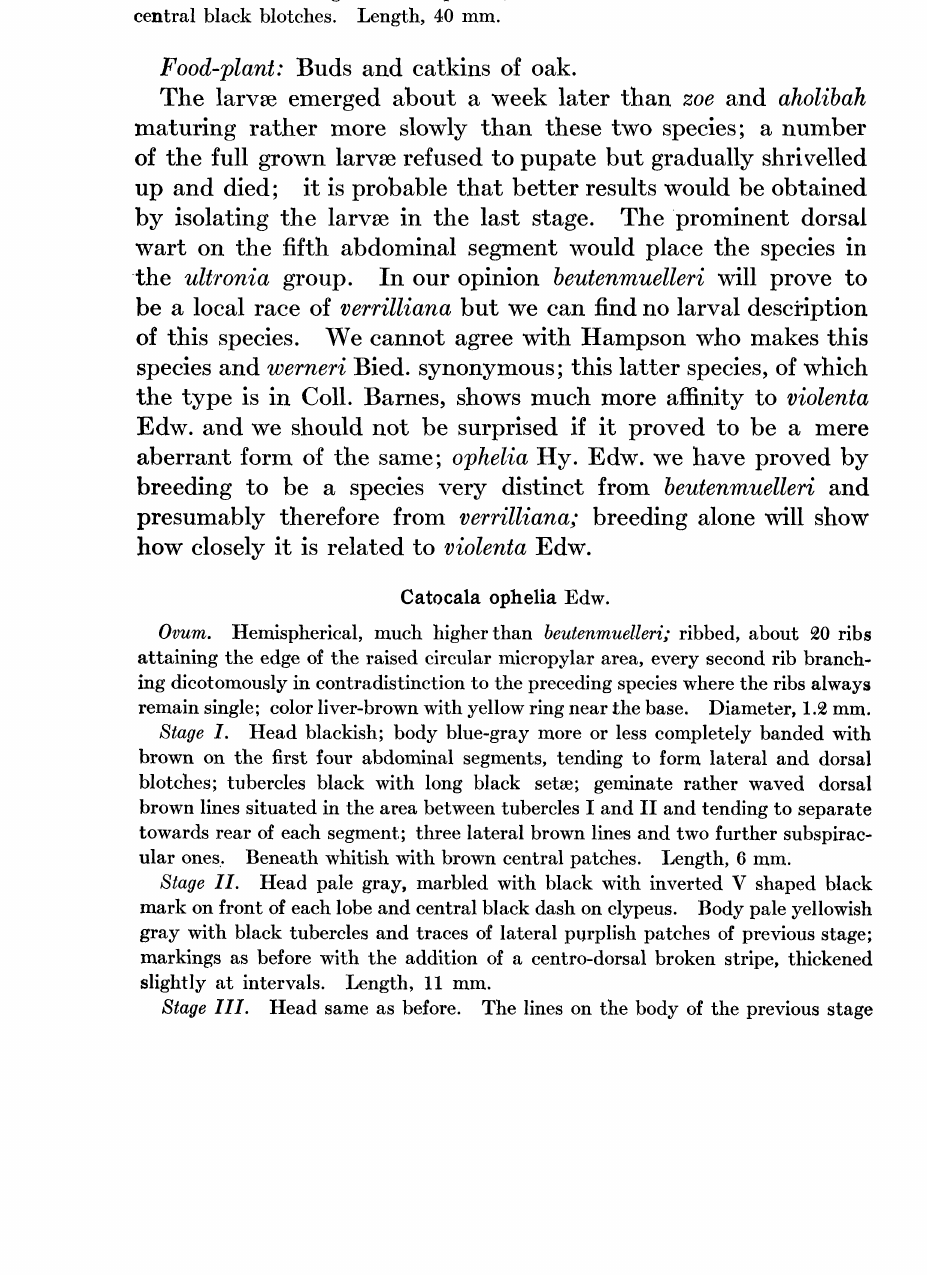
stages; a very prominent fleshy beak-like wart on 5th abdominal segment shaded with black and with black posterior markings extending obliquely downward over the anterior portion of the following segment; laterally the 5th segment is shaded with light brown extending between the prolegs on to the 6th segment; prom- inent conical dorsal tubercles on the 8th abdominal segment with lunate brown mark behind extending to above spiracle; filaments whitish; beneath white with central black blotches. Length, 40